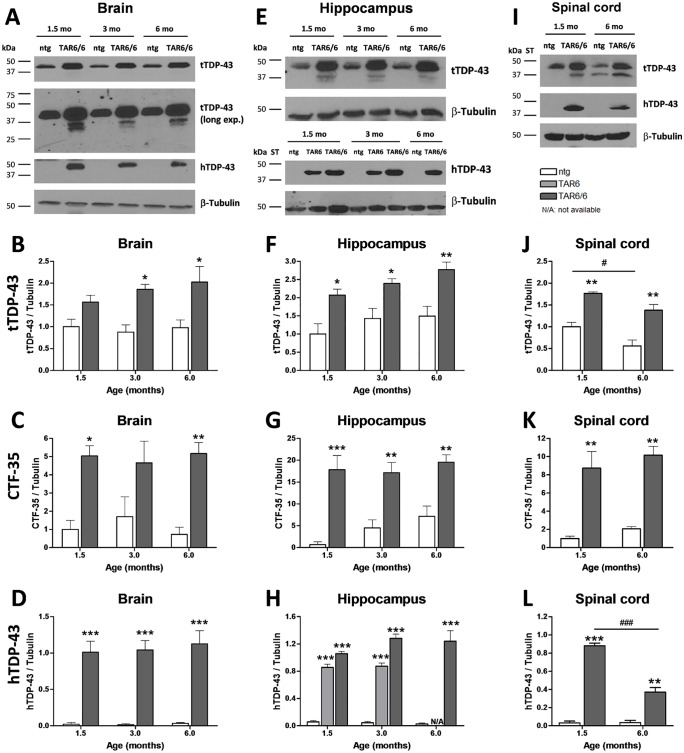
Densitometric analysis of tTDP-43, CTF-35 and hTDP-43 expression in ntg, TAR6 and TAR6/6 mice.(A) Brain homogenates, (E) hippocampal and (I) spinal cord homogenates from ntg, TAR6 and TAR6/6 mice at the age of 1.5, 3 and 6 months were analyzed by Western blotting and probed with the indicated antibodies (long exp. = long time ECL exposure for 30 min). One representative example of 3 is shown. Densitometric analysis of tTDP-43, CTF-35 and hTDP-43 levels normalized to β-tubulin levels of brain (B- D), hippocampal (F-H) and spinal cord (J-L) homogenates. Two-way ANOVA followed by Bonferroni‘s post-hoc test. Mean+SEM. *significances between genotypes, #significances between age groups. *p<0.05, **p<0.01, ***p<0.001.